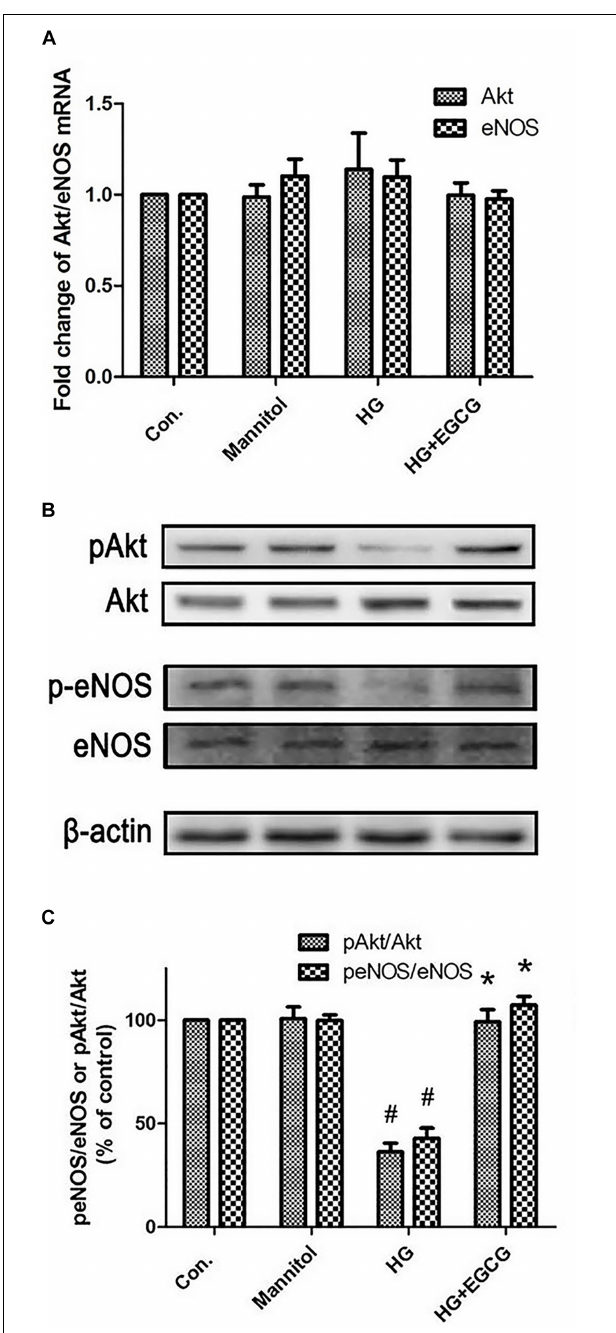
FIGURE 5 | EGCG re-activates Akt-eNOS pathway blocked by high glucose treatment. (A) RT-PCR shows the relative expression of Akt and eNOS mRNA, which were not changed significantly between the different groups. (B,C) Western blot reveals the phosphorylation of Akt and eNOS were blocked by HG treating, and recovered by 40 µ M EGCG co-incubation for 72 h. # P < 0.05 compared to the control group, ∗ P < 0.05 compared to the HG